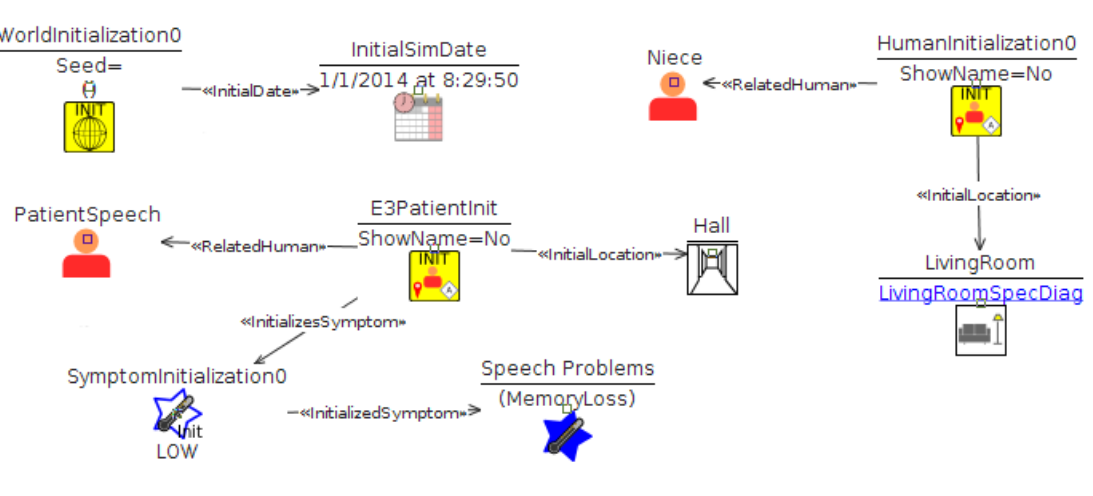
Figure 9. Representing the speech interaction.